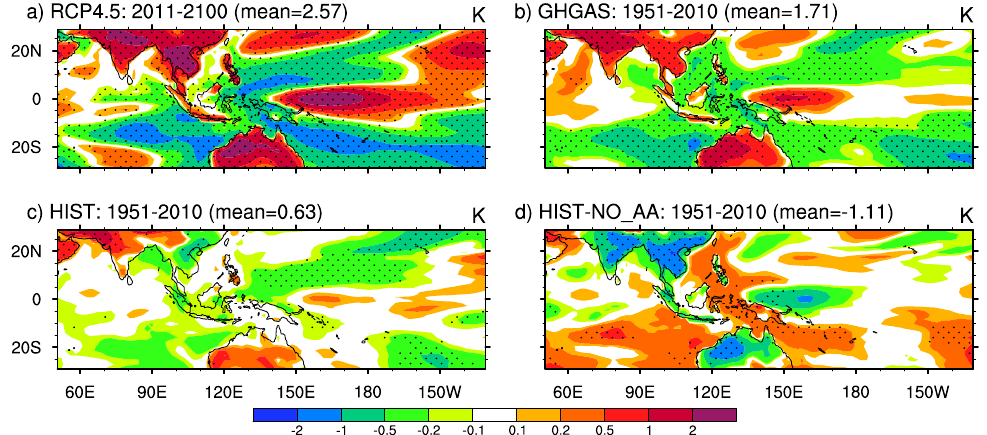
Fig. 15. Ensemble-mean DJFM trends of T s with the low-latitude (30 ◦ S–30 ◦ N) mean T s trend subtracted (i.e. T rel ), from (a) RCP4.5 (2011– 2100), (b) GHGAS (1951–2010), (c) HIST (1951–2010), (d) HIST minus NO AA (1951–2010). The low-latitude mean T s trend for each ensemble is shown in its header (Kcentury − 1 ). Stippled trends are significantly different from the low-latitude mean at